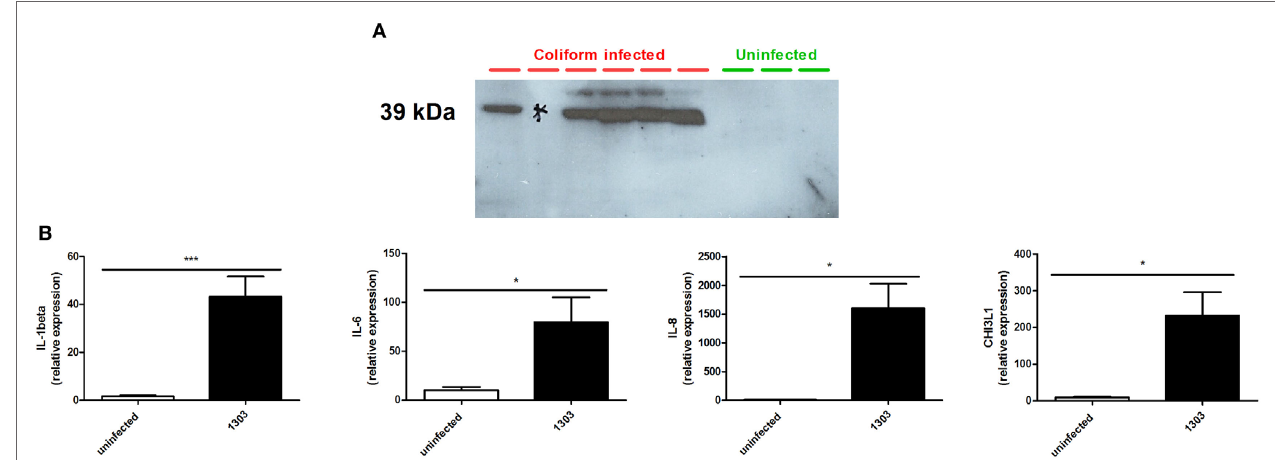
FigUre 1 | Chitinase 3-like 1 (CHI3L1) in coliform-infected bovine samples. (a) Bovine CHI3L1 protein detection in whey isolated from naturally coliform-infected cows ( n = 6) compared to whey isolated from healthy quarters ( n = 3). (b) interleukin (IL)-1beta, IL-6, IL-8, and CHI3L1 expression in Escherichia coli 1303 experimentally infected cows ( n ≥ 4). Data are presented as means ± SEM, indicating significant differences with *( P <